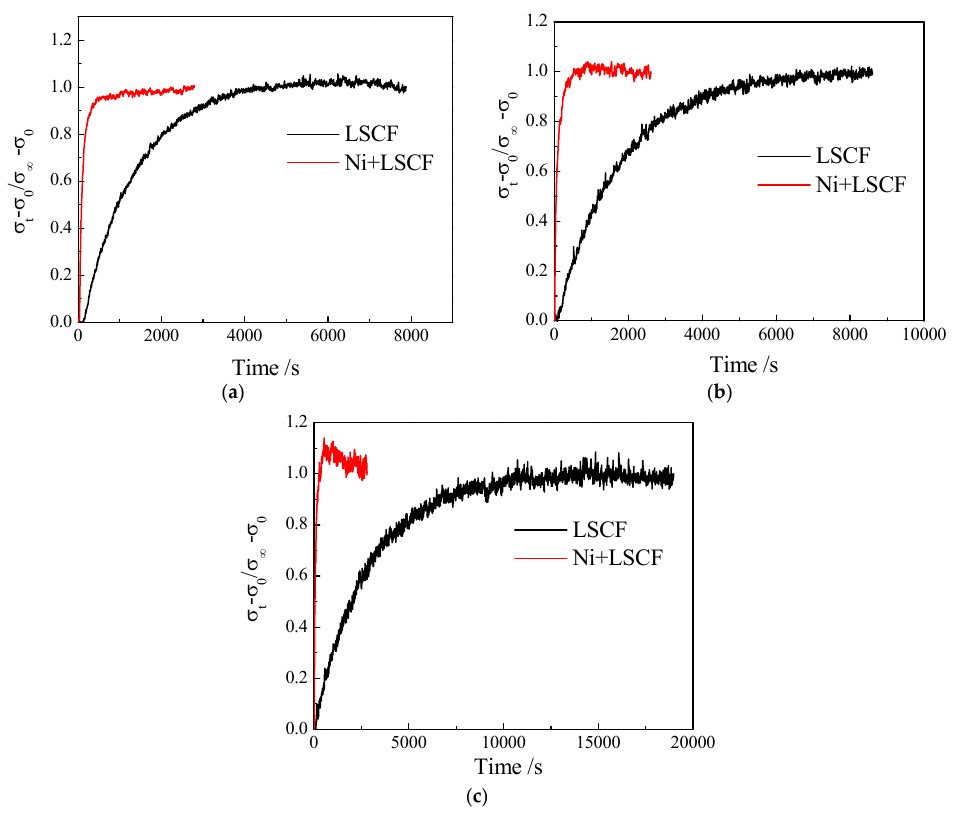
Figure 4. The electric conductivities relaxation curves for both the uncoated (black) and Ni ‐ coated (red) samples at ( a ) 800 °C, ( b ) 750 °C, and ( c ) 700 °C.